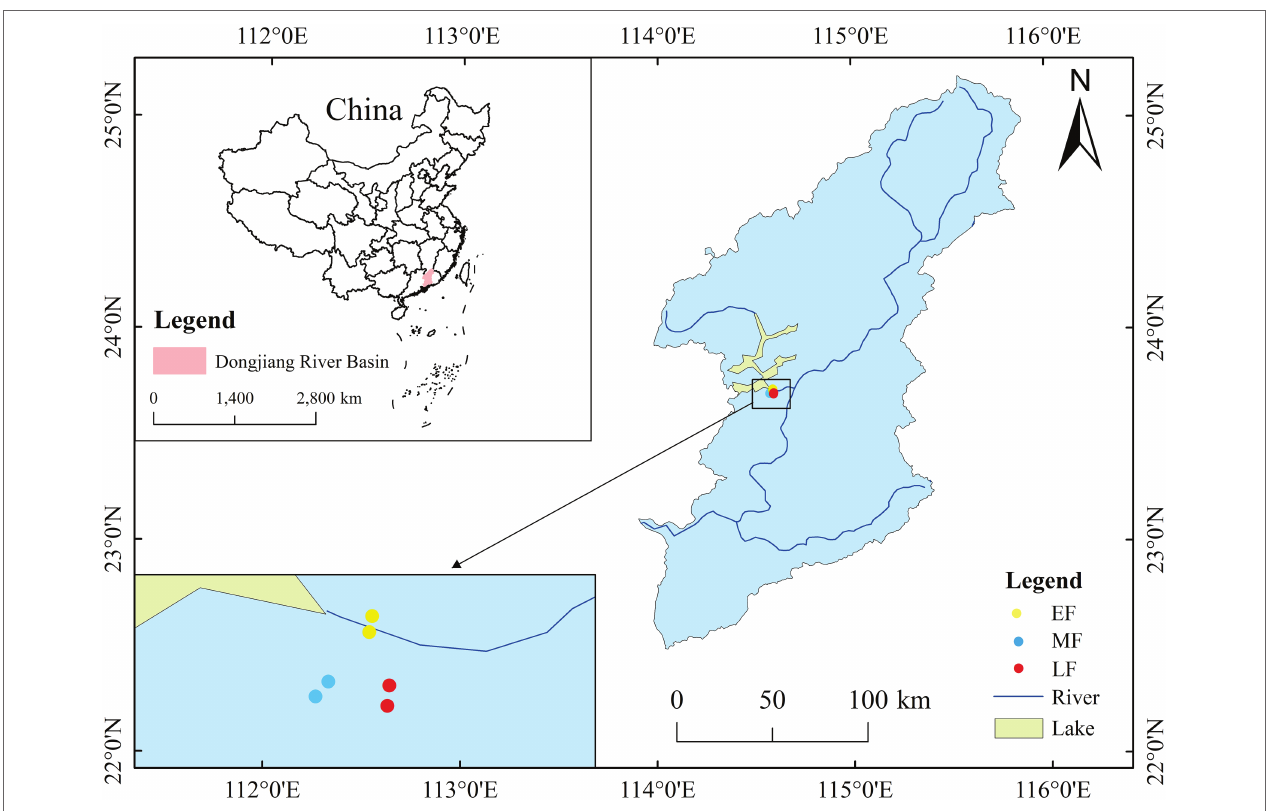
FIGURE 1 | Location of the study area at the Xinfengjiang National Forest Park, Guangdong Province,